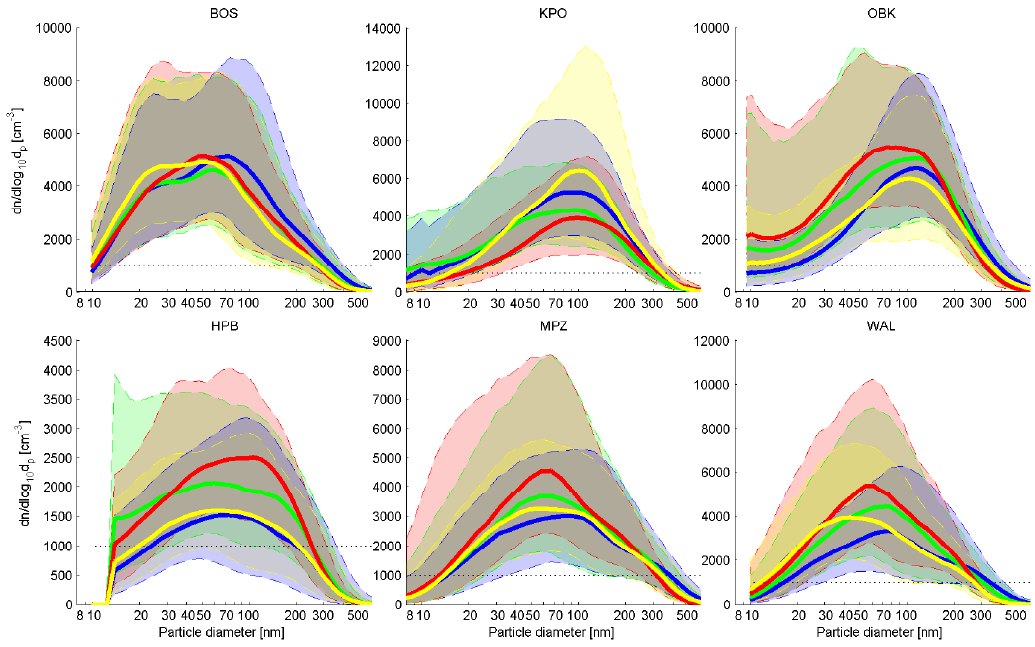
Fig. 5. Median distributions (solid line) and 16th and 84th percentile distributions (shaded areas) divided by seasons at Central European stations. Notation as in Fig.